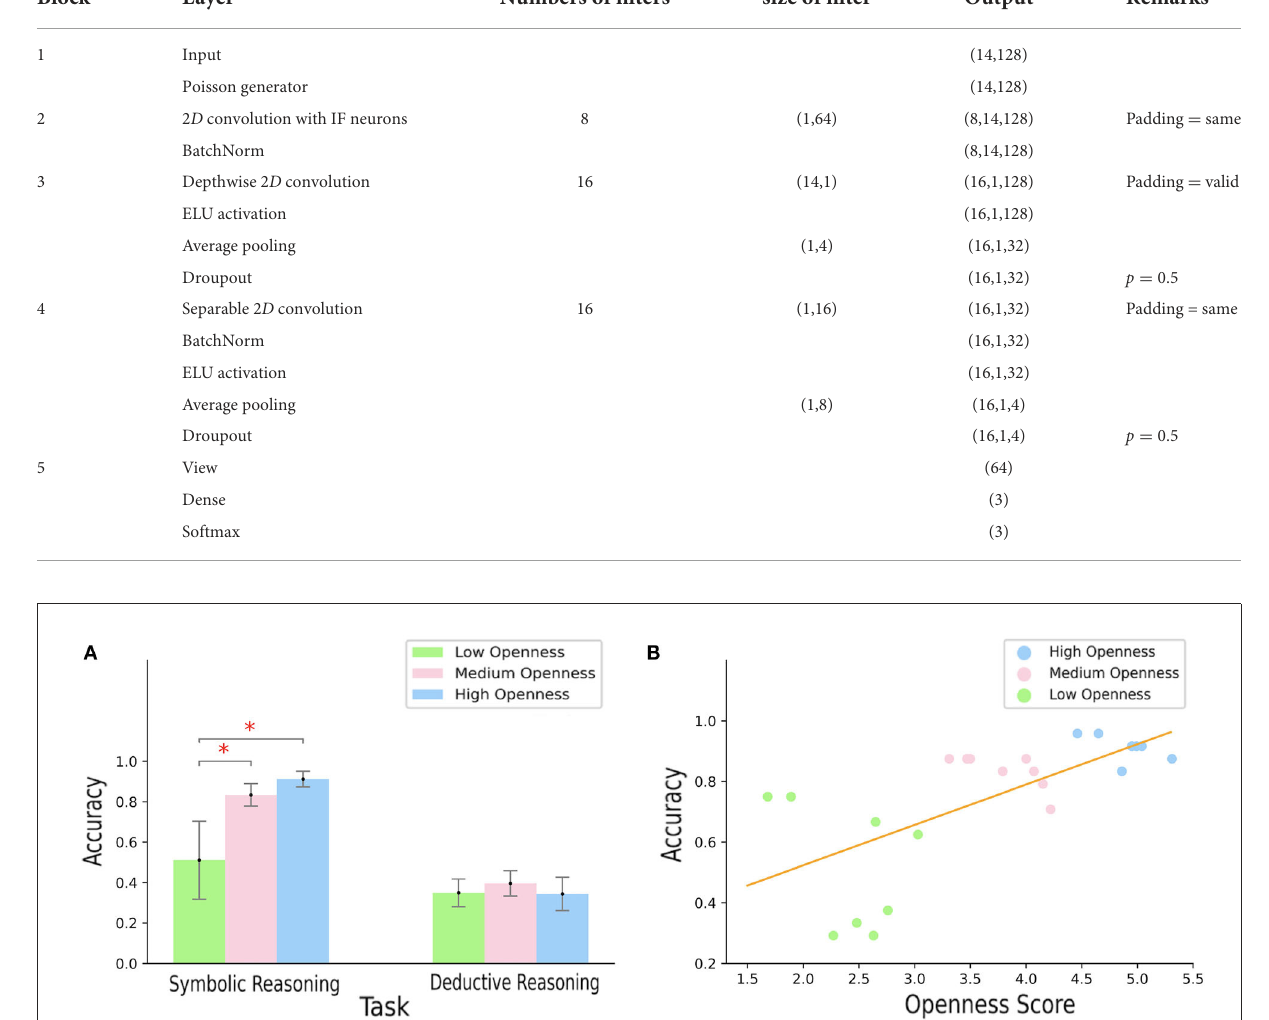
significant over F7/8, F3/4 (both p < 0.05). No significance was found in other